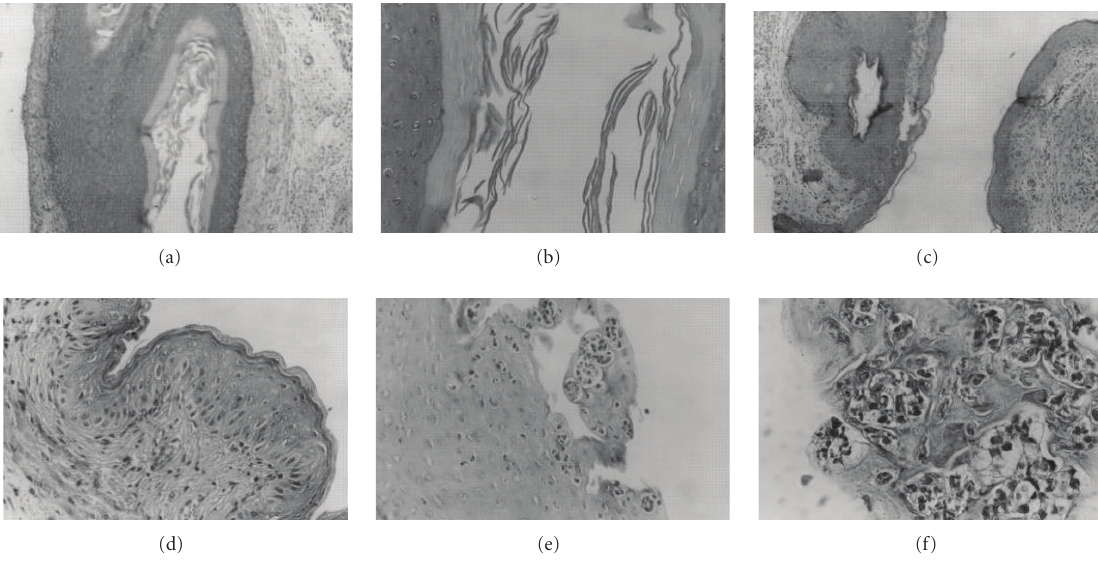
Figure 4: Light microscopy photographs of histological slices stained with hematoxylin-eosin showing the mucosa structure of the vaginas of mice that were inoculated with lactobacilli and/or staphylococci. (a), (b) Lactobacilli treated groups at 10X and 100X, respectively. (c), (d) Lactobacilli + pathogen treated groups at 40X and 100X. (e), (f) Pathogen treated groups at 40X and 100X magnifications, respectively. For details see Materials and